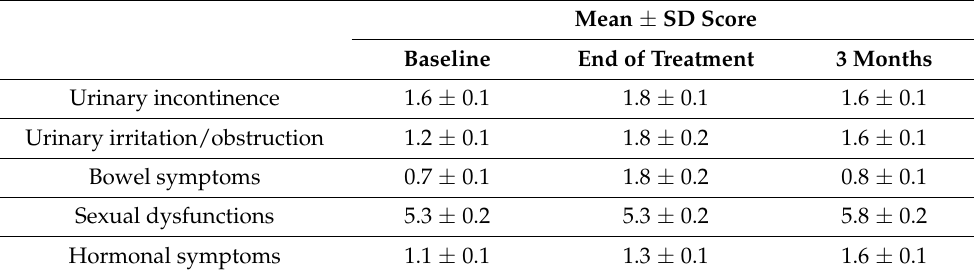
Table 4. Patients reported HRQOL using